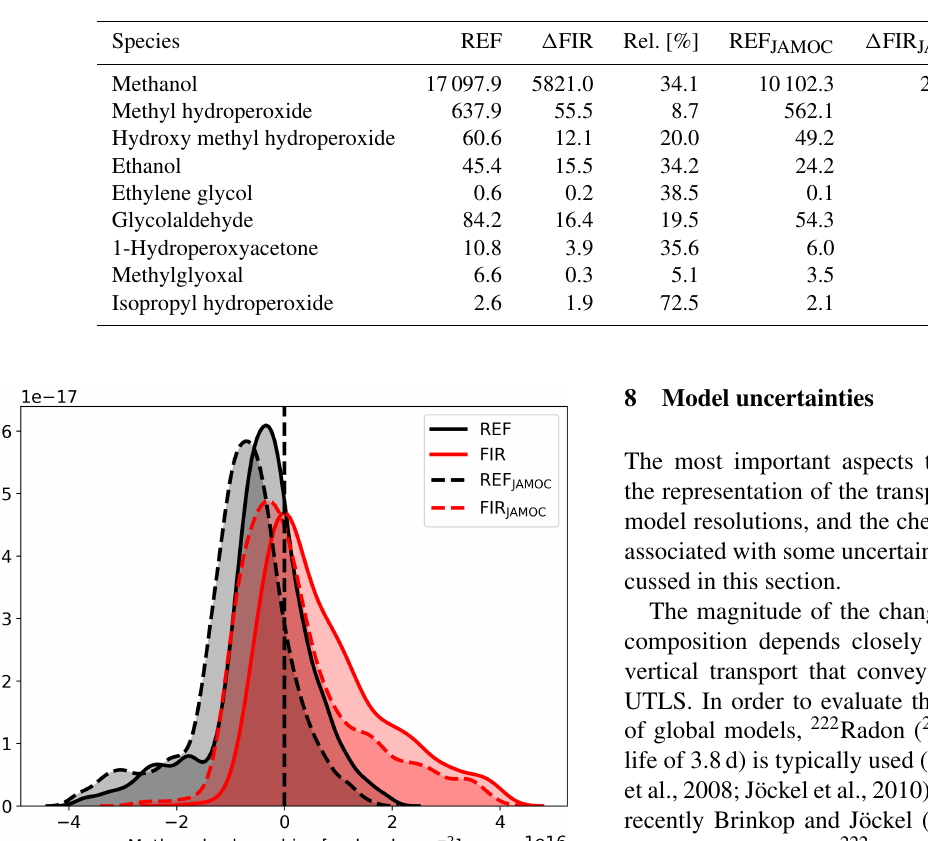
Table 6. The lower stratospheric burden in November with and without VOC biomass burning emissions of OVOCs explicitly reacting in JAMOC. The stratospheric burden is given in megagrams (Mg).